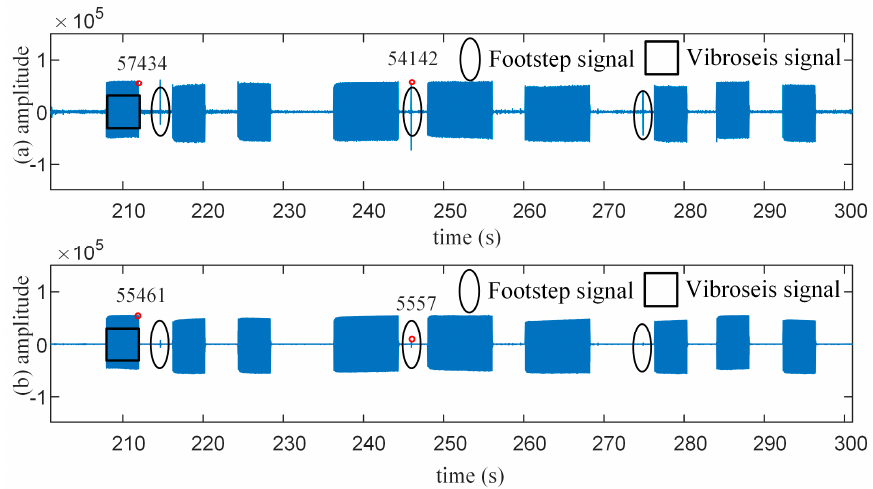
Figure 3. The amplitude changes of signals before and after filtering; ( a ) Vibroseis signals and footstep signals before filtering; ( b ) Vibroseis signals and footstep signals after filtering.